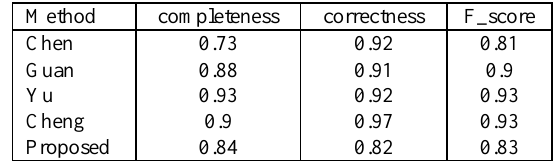
Table 12. Comparison with the other methods.